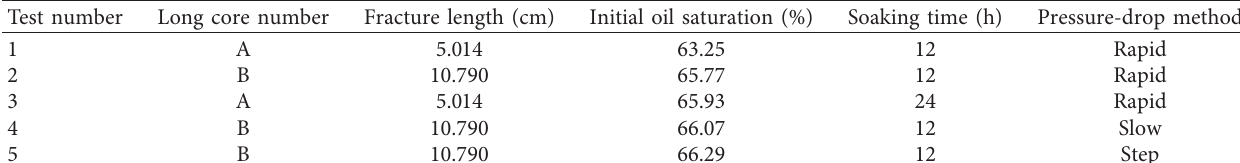
Table 2: Conditions of CO 2 huff-and-puff tests at the reservoir temperature of 61